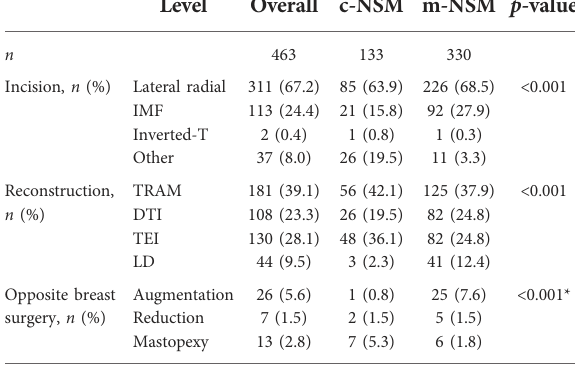
TABLE 2 Operative details by mastectomy type ( N =463).